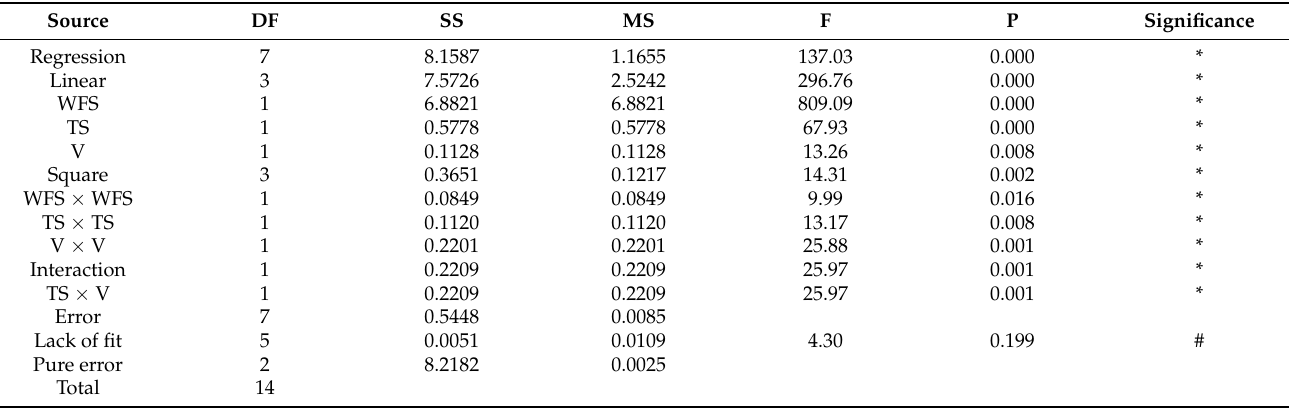
Table 5. ANOVA for bead height (BH).